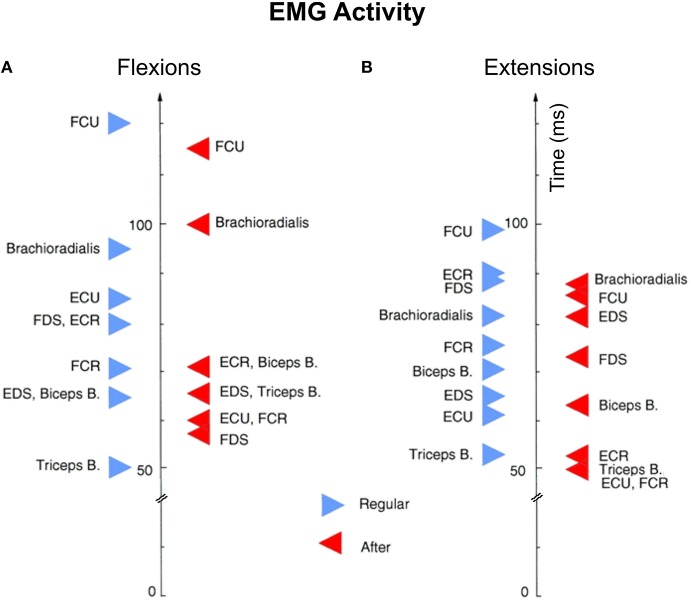
Average onsets of electromyographic (EMG) activity. EMG activity between flexion (A) and extension (B) movements for both certain and uncertain reward trials. Each triangle (red for certain and blue for uncertain reward trials) represents the average EMG onset for at least 40 trials recorded consecutively. Biceps B, biceps brachii; BR, brachioradialis; ECR, extensor carpi radialis; ECU, extensor carpi ulnaris; EDS, extensor digitorum superficialis; FCR, flexorcarpi radialis; FDS, flexor digitorum superficialis; FCU, flexor carpi ulnaris; FDS, flexor digitorium superficialis; Triceps B, triceps brachii.